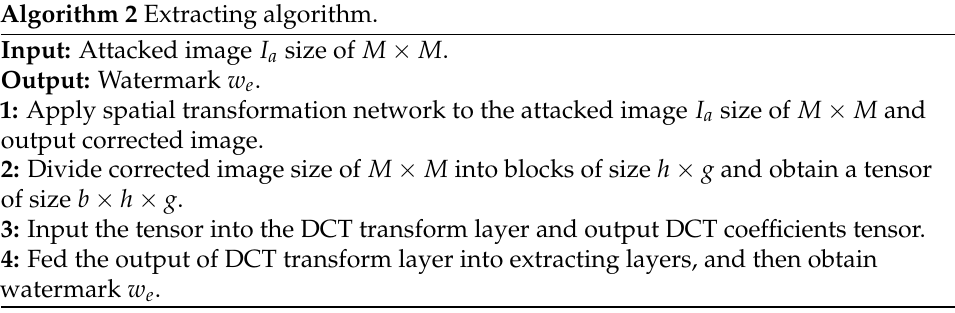
Algorithm 2 Extracting